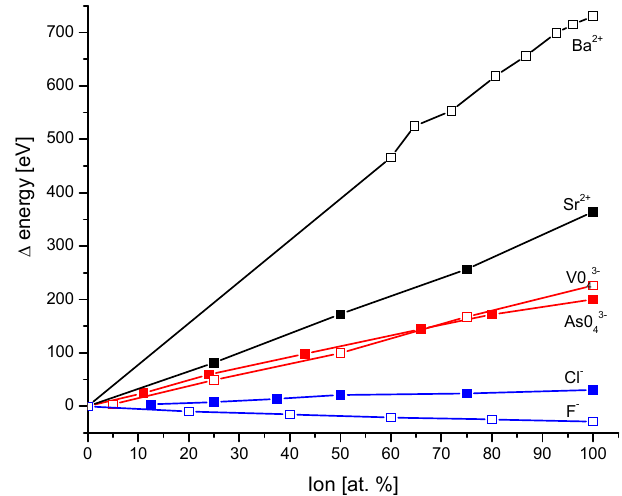
Figure 1. Energy changes during cationic substitutions (black), anionic substitutions (red), and substitutions in channel positions (blue) of apatites. Figure based on data presented in: for F ‐ from [35], for Cl − from [34], for AsO 43 − from [30], for VO 3 − from [31], for Sr 2+ from [32], and for Ba 2+ from [33].